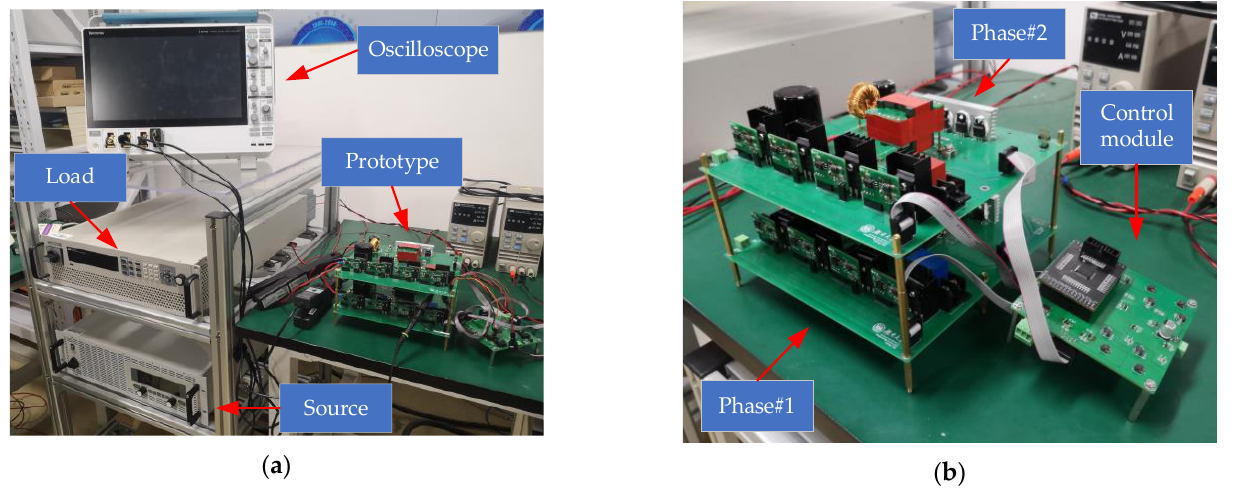
Figure 20. Simulation result of